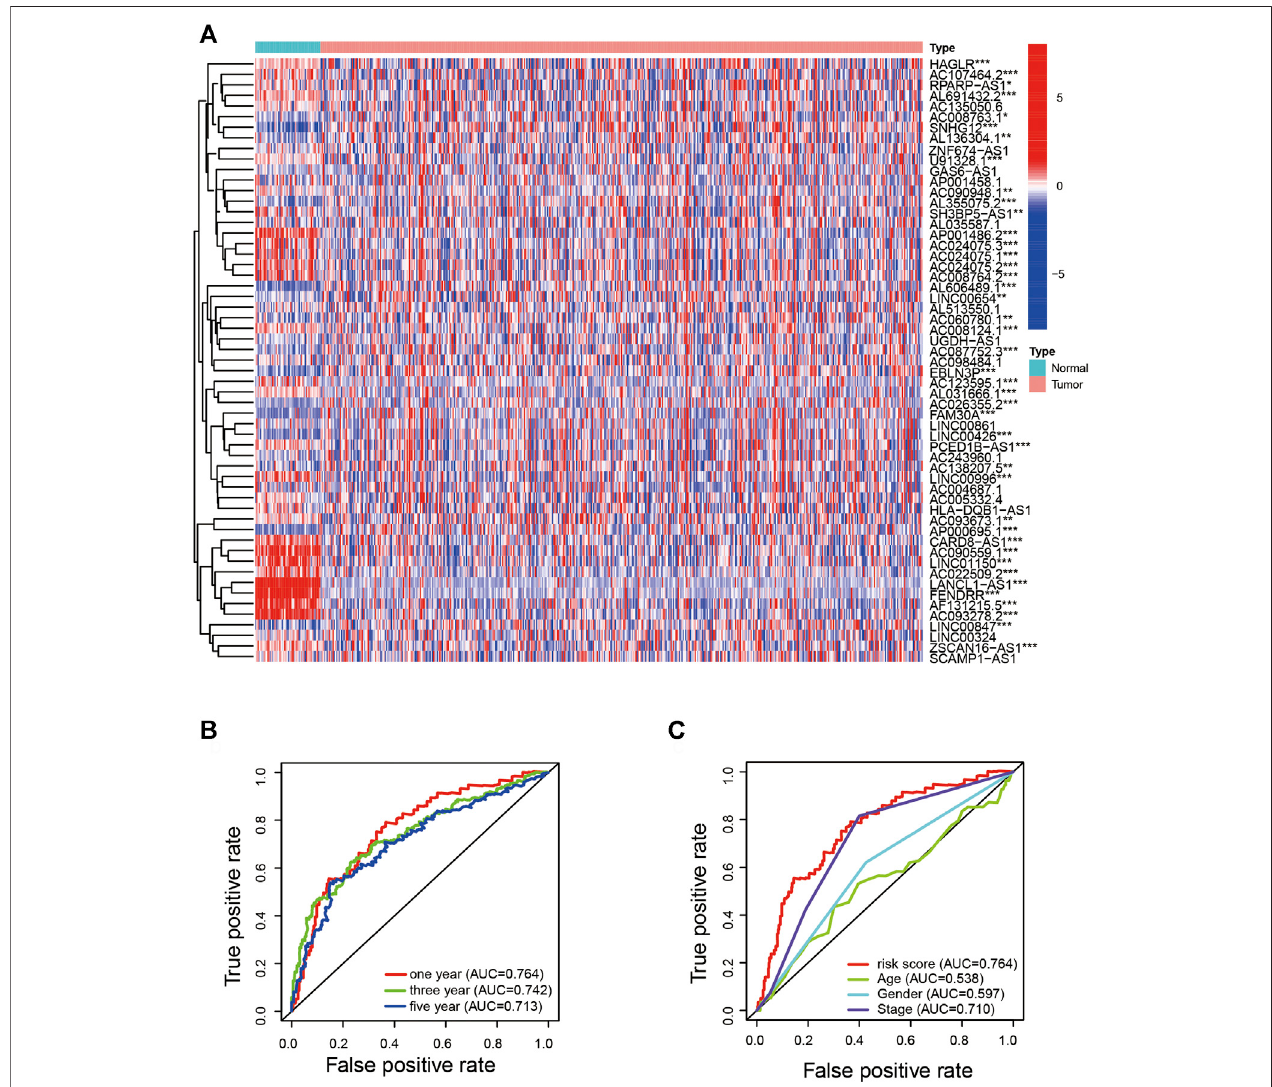
FIGURE2| Identi fi cationoftheARlncRNAsignature. (A) HeatmapshowstheexpressionofARlncRNAsrelatedtosurvivalinLUADandnormalsamples. (B) The1-, 3-, and 5-year AUC values were > 0.7. (C) Compared with AUC of age, sex, and stage, the 1-year AUC value was the maximum.